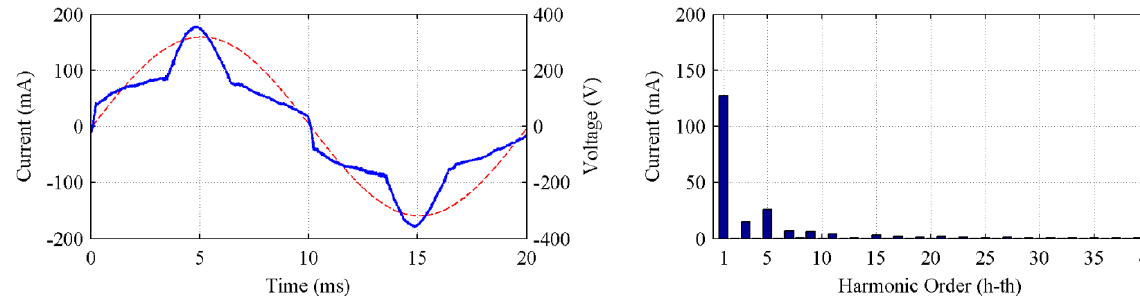
Figure 12. CFL-B: Current waveform and its harmonic